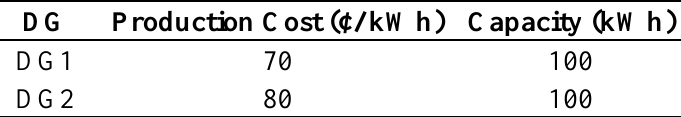
Table 5. DG information of Cases 1–4.